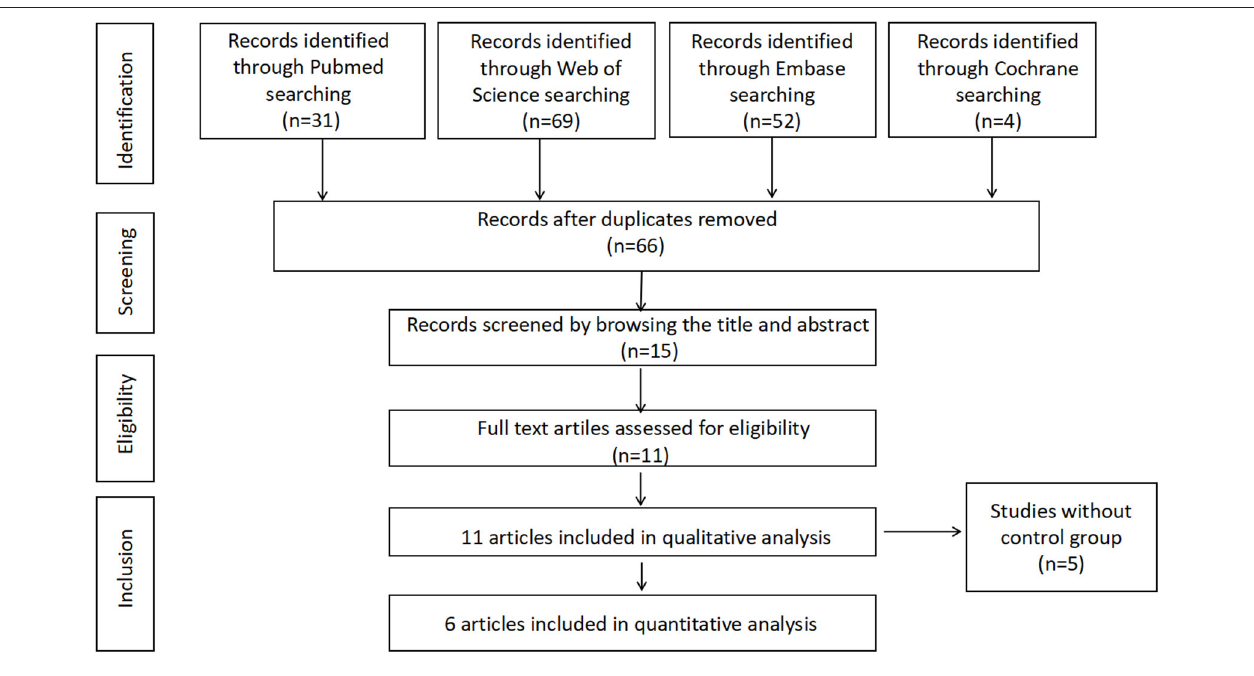
FIGURE 1 | Flow chart of study inclusion in systematic review and meta-analysis.